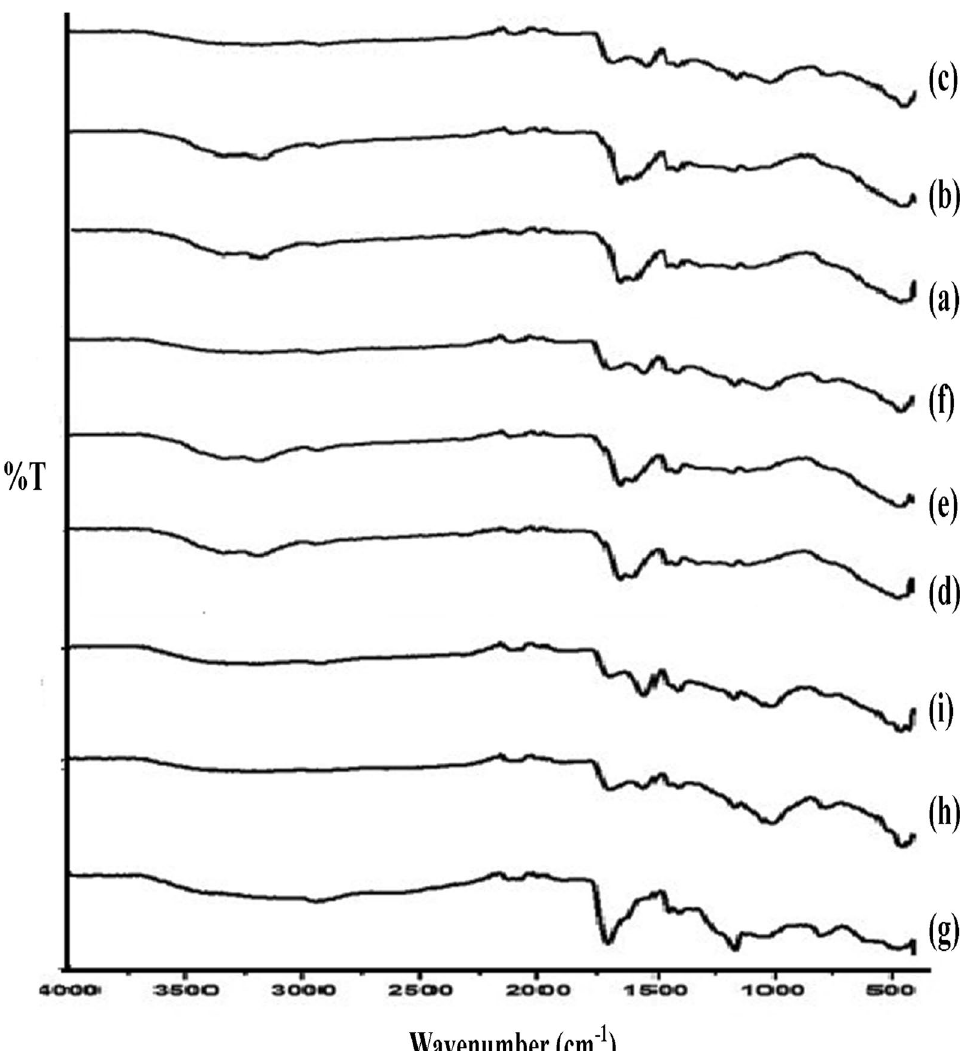
Fig. 7 a–i FT-IR spectra of biodegradation of a Av-cl-poly(AA) stage-I; b Av-cl-poly(AA) stage–II and c Av-cl-poly(AA) stage-III using soil burial method d Av-cl-poly(AA) stage-I; e Av-cl-poly(AA) stage–II and f Av-cl-poly(AA) stage-III using composting method; g Av-cl-poly(AA) stage-I; h Av-cl-poly(AA) stage–II; and i Av-cl-poly(AA) stage-III using vermicomposting